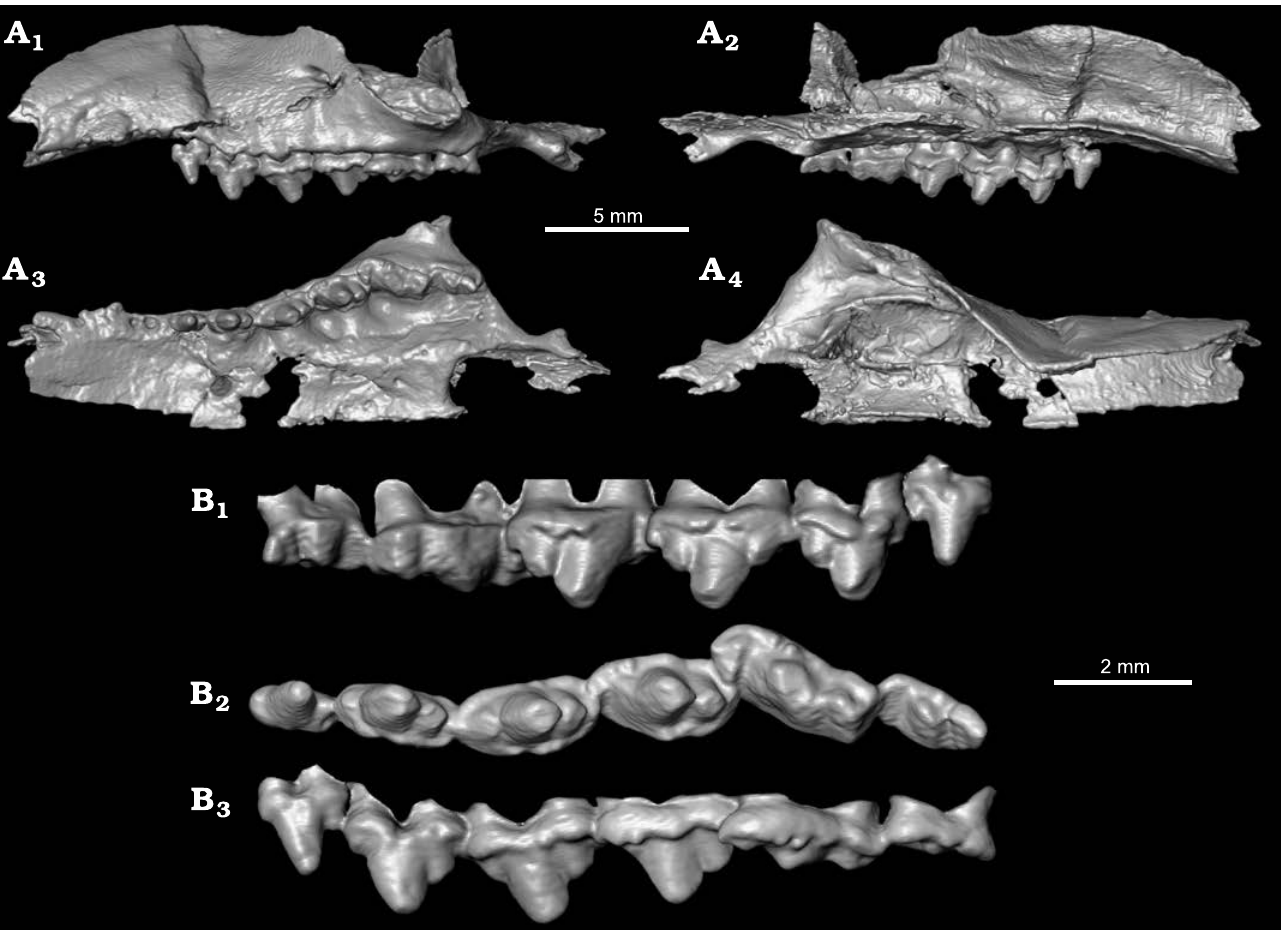
Fig. 2. 3D surface renderings from CT data of the morganucodontan mammaliaform Cifellilestes ciscoensis gen. et sp. nov. (OMNH 69352), from the Cisco Mammal Quarry, Utah, USA, Upper Jurassic Morrison Formation. A . Left skull fragment in lateral (A 1 ), medial (A 2 ), ventral (A 3 ), and dorsal (A 4 ) views. B . Dentition only in lingual (B 1 ), occlusal (B 2 ), and buccal (B 3 )